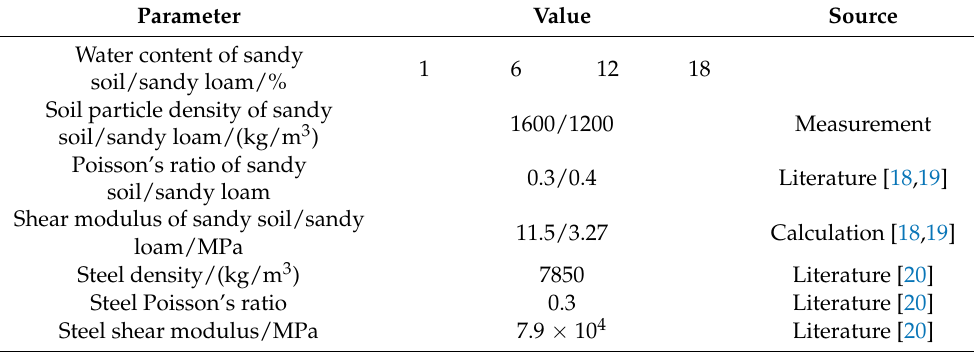
Table 3. Simulation